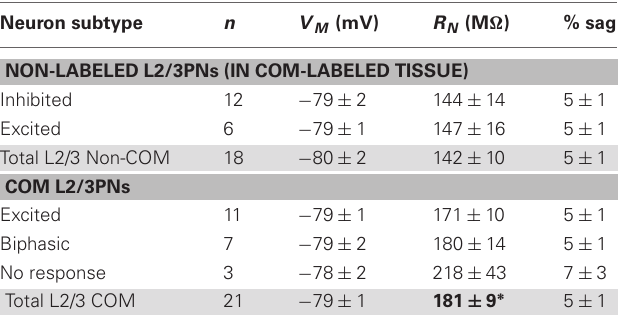
Table 2 | Physiology and serotonergic responsiveness of